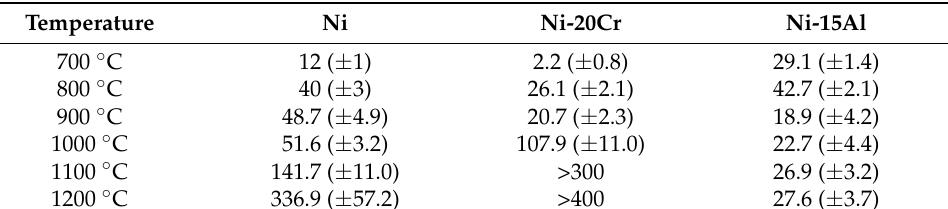
Table 2. Thicknesses of oxide scales ( µ m) on Ni, Ni-20Cr, and Ni-15Al alloys after oxidation at temperatures ranging from 700 ◦ C to 1200 ◦ C for 576 h.